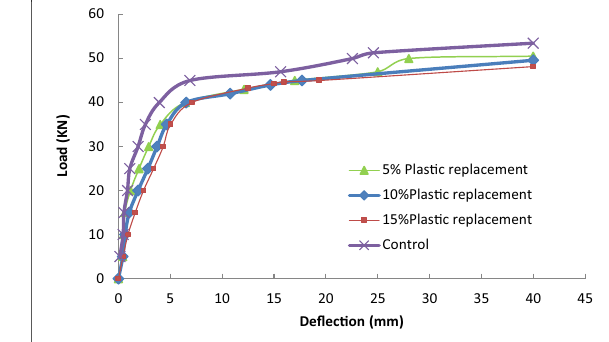
Fig. 14 Load–deflection for beams with granular plastic waste.